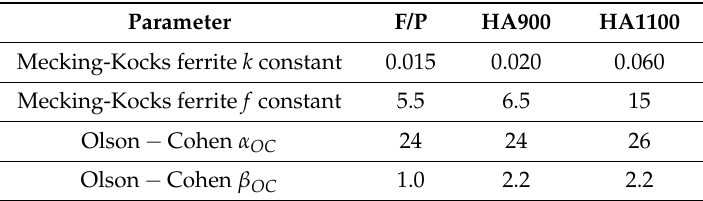
Table 8. Calibrated parameters for the current